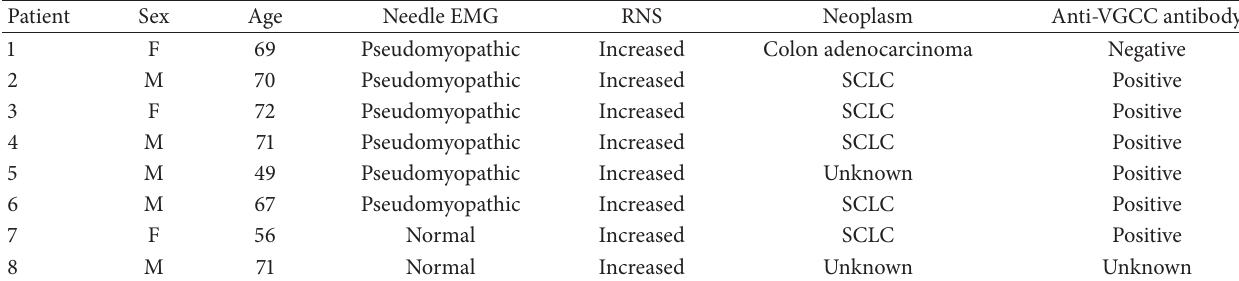
Table 1: Characteristics of patients.